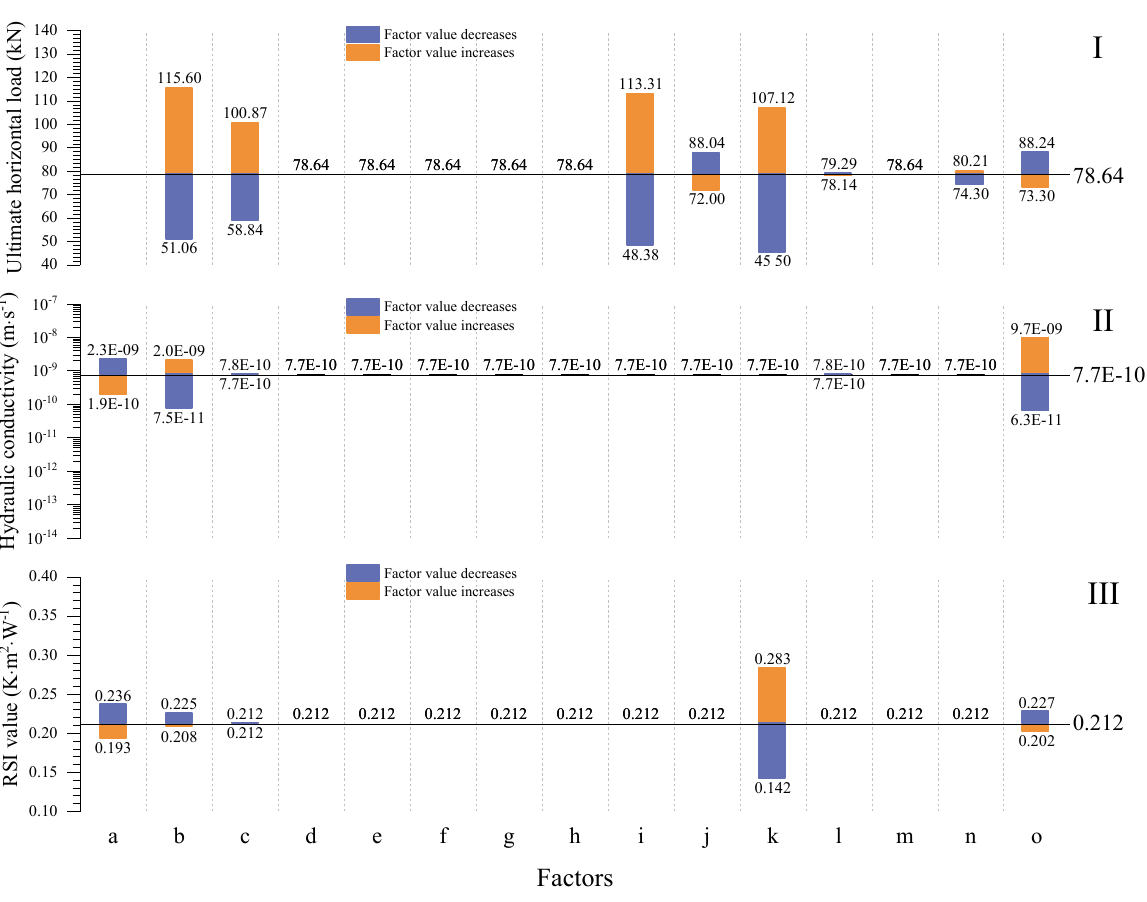
Figure 5. Variations of ( I ) the pushover strength, ( II ) the average hydraulic conductivity, and ( III ) the average RSI value of URE walls according to different factors. (a) Dry density, (b) fine content, (c) vertical load, (d) emissivity, (e) incoming shortwave radiation, (f) Munsell color value, (g) cloud cover, (h) outdoor wind speed at 10 m, (i) wall width, (j) wall height, (k) wall thickness, (l) average annual outdoor temperature, (m) average annual outdoor relative humidity, (n) ground surface suction, and (o) initial saturation of the wall.